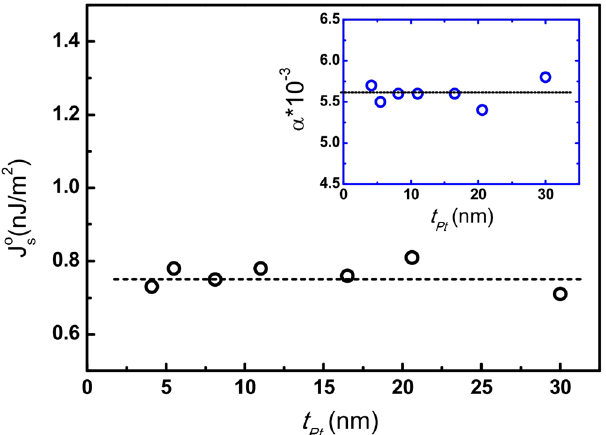
0 for the series of LSMO(20 nm)/Pt( t s